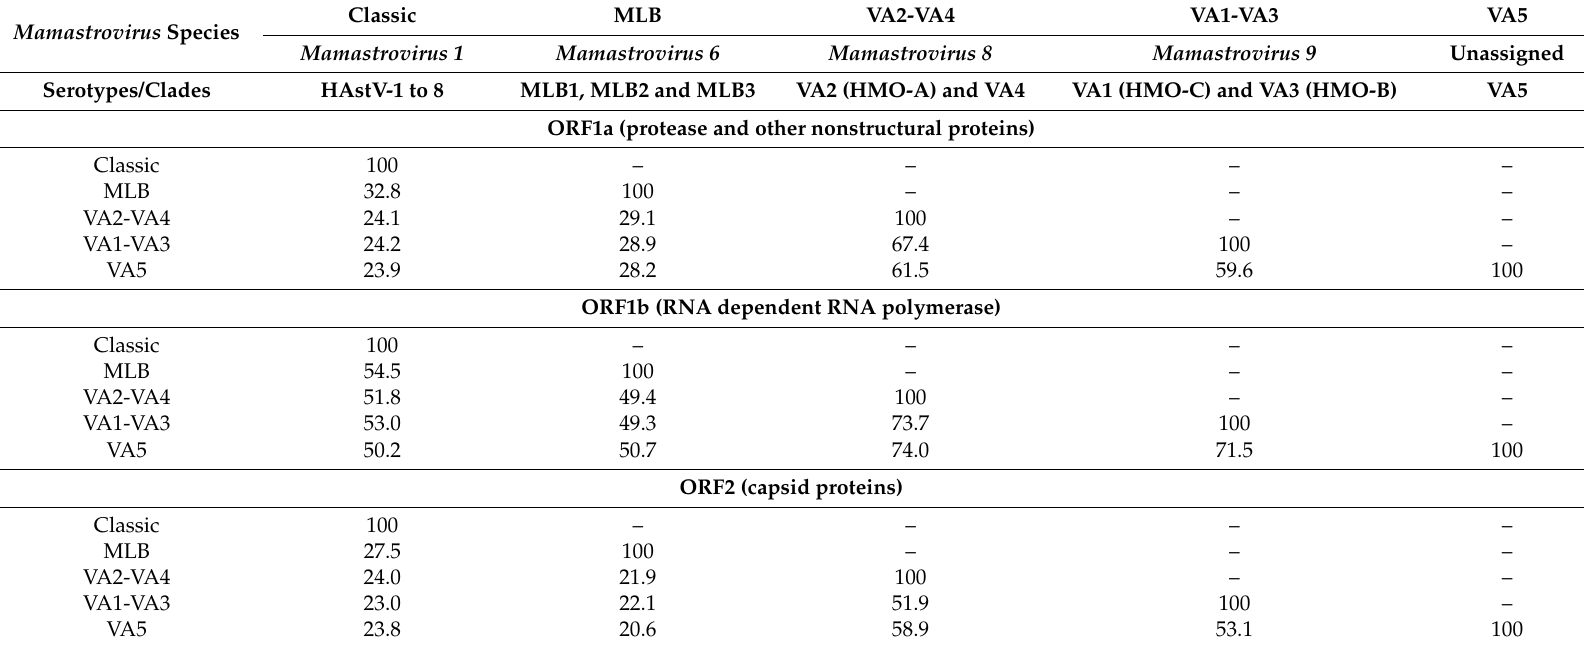
Table 1. Amino acid sequence identity between classic HAstVs, MLB-HAstVs (Human astrovirus Melbourne) and VA-HAstV (Human astrovirus Virginia), for the 3 open reading frames (ORFs). Representative members of each group were used for calculations (Classic: L23513, L13745, AF141381, AY720891, DQ028633, serotypes and clades into the different International Committee on Taxonomy of Viruses (ICTV) recognized species within the Mamastrovirus genus is